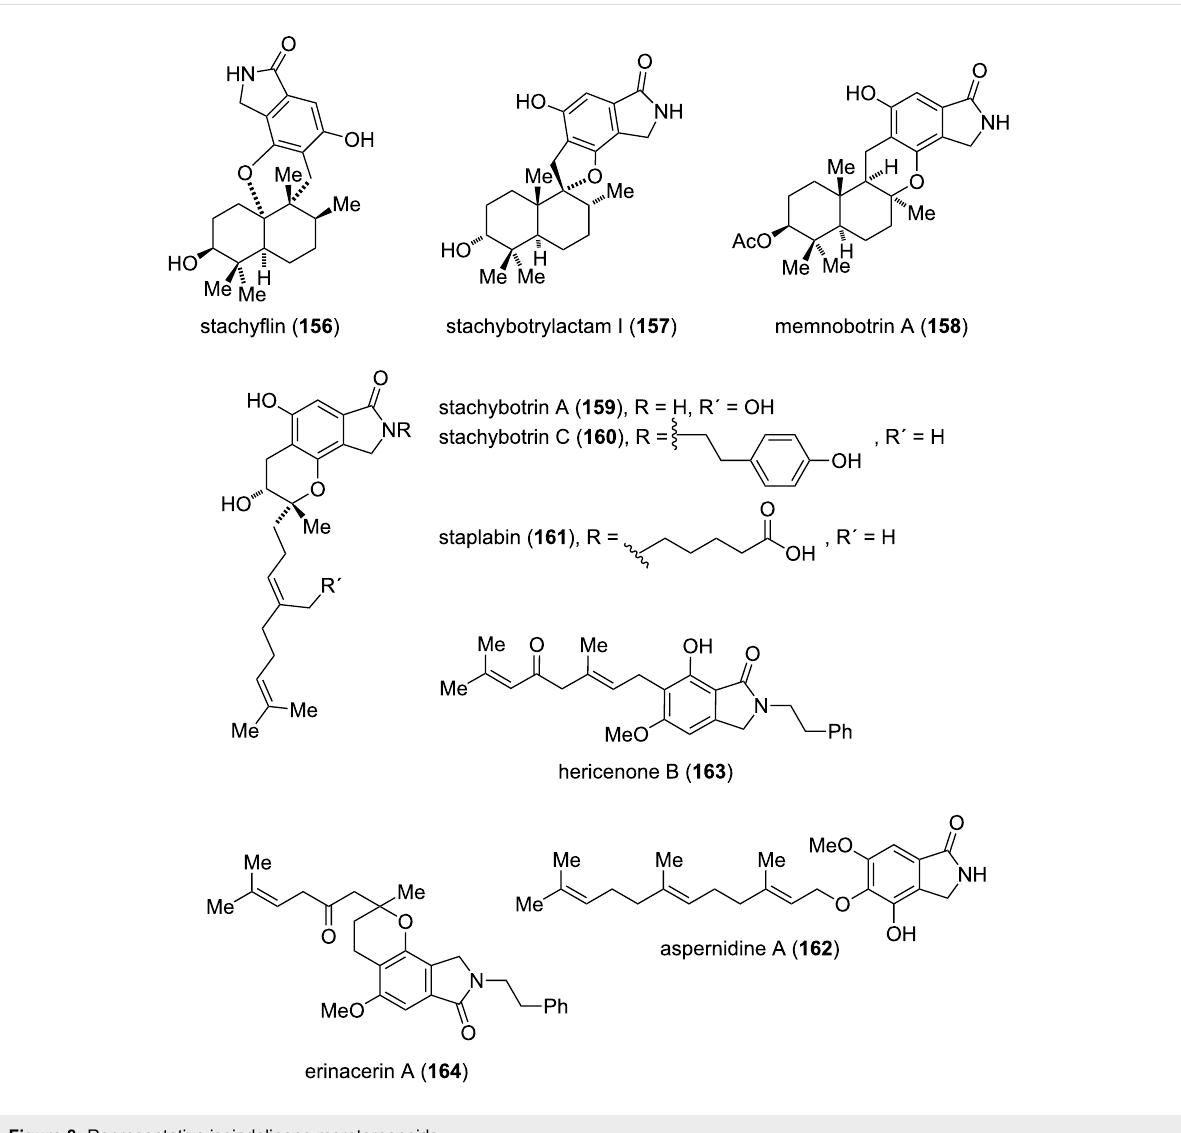
Figure 8: Representative isoindolinone